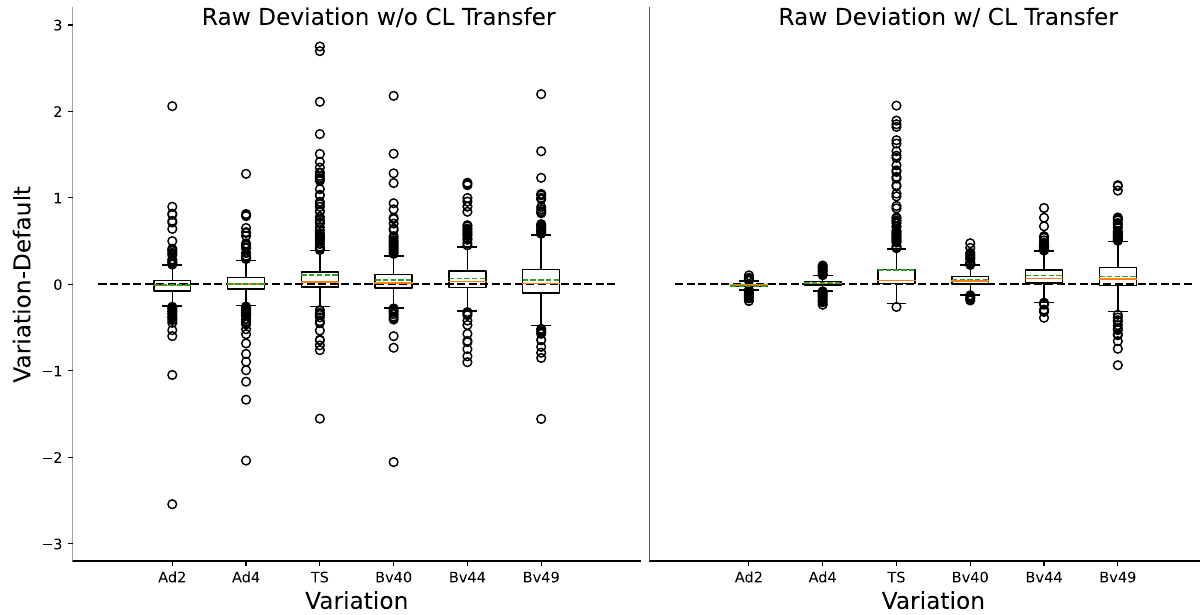
Figure 3. Boxplot of the rescaled raw prediction difference between the default configuration and all variation configurations (Ad2, Ad4 = ADMIRE strength of 2/4; TS = true stack; Bv40, Bv44, Bv49 = different reconstruction kernels), with and without centerline